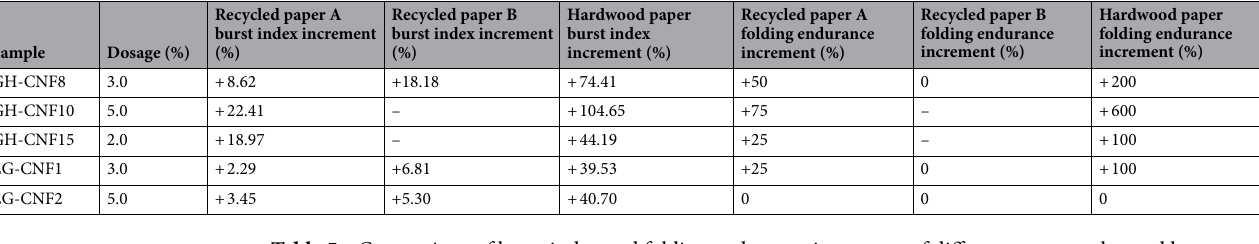
Table 5. Comparison of burst index and folding endurance increment of different papers enhanced by identical CNFs of same dosages. (For each value, a total number of 30 parallel experiments were done and the numbers shown were mean